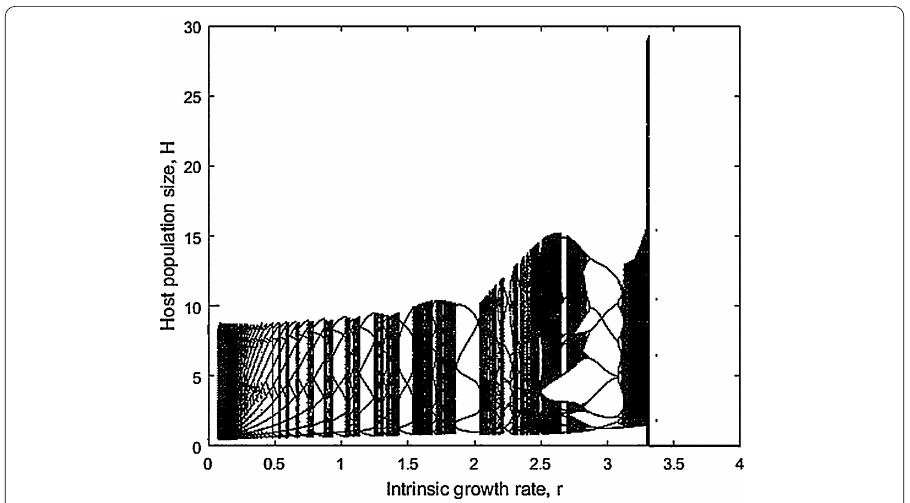
Figure 2 Bifurcation diagram of the host population in the Holling type III host-parasitoid model (3.1) for 0 ≤ r ≤ 4, T = 5